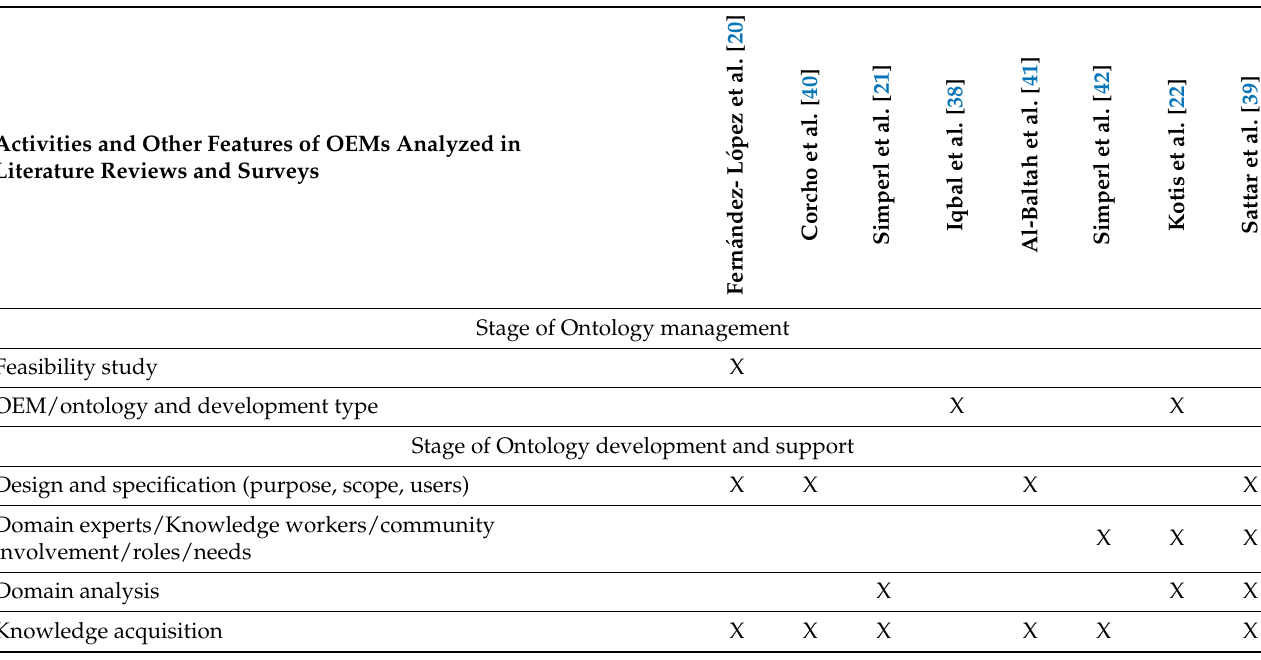
Table 1. Criteria traced in in reviews and surveys of OEMs, organized according to the stages of ontology engineering and other features considered (references in table are temporally